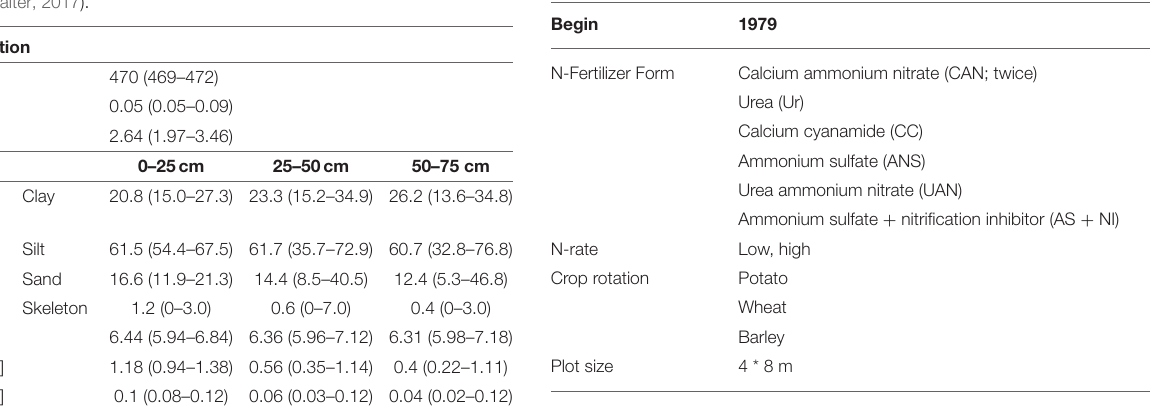
TABLE 2 | Basic features of the long term N-fertilization experiment.